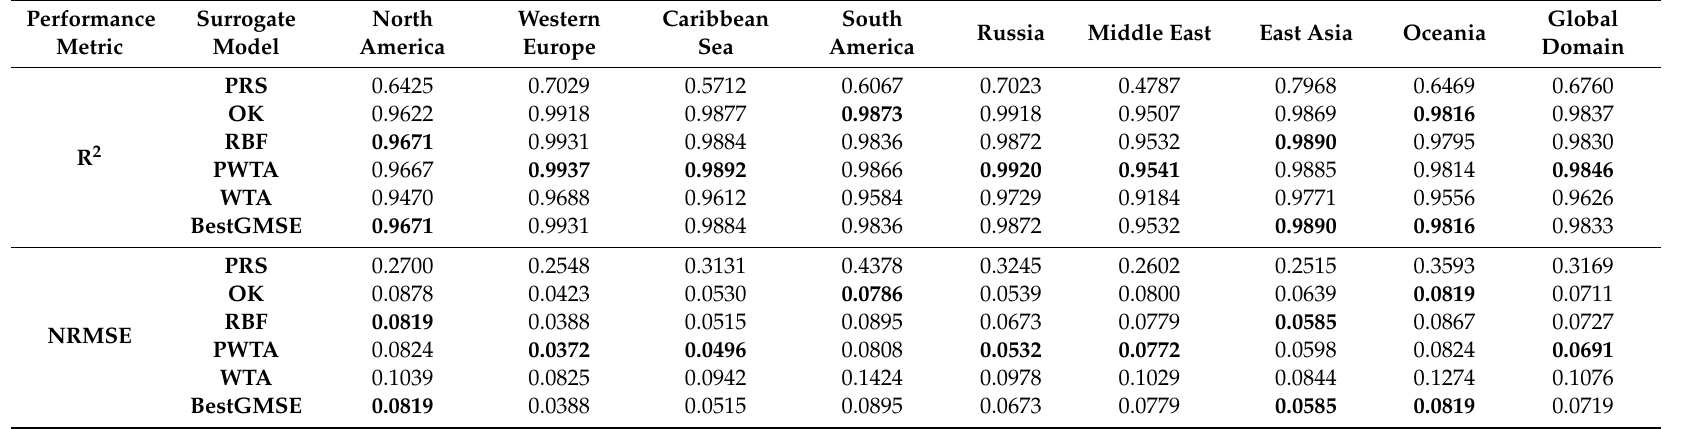
Table 6. Comparisons of R 2 and NRMSE for di ff erent